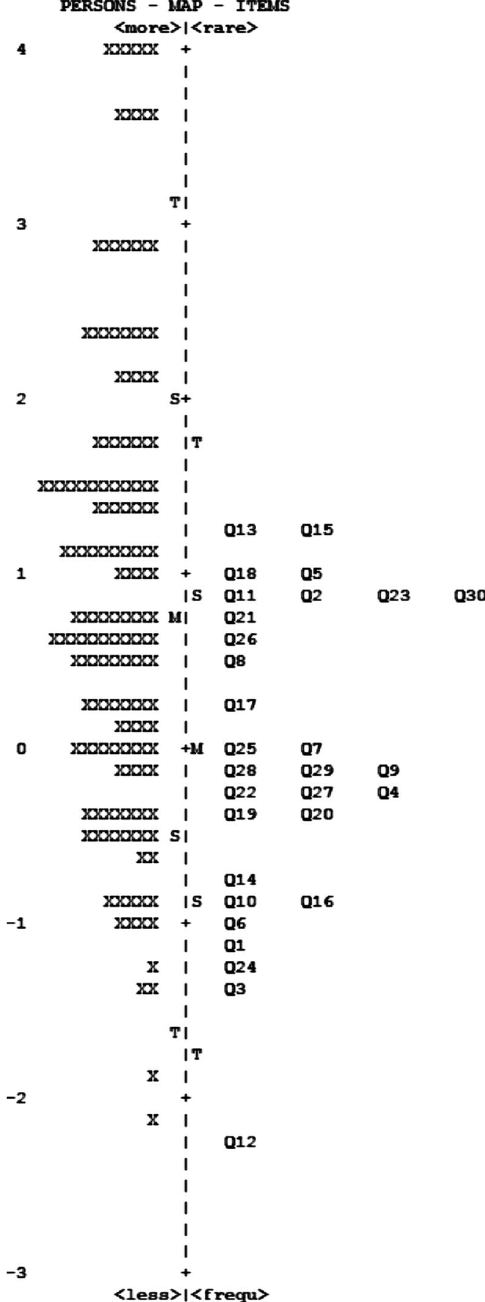
FIG. 5. Item-person map for the university students. The left- hand side shows the distribution of student abilities and the right- hand side shows the distribution of item difficulties. Items are la- beled as Q1–Q30. M, S, and T are labels for the mean value, one standard deviation, and two standard deviations of each distribution. Each “x” represents one